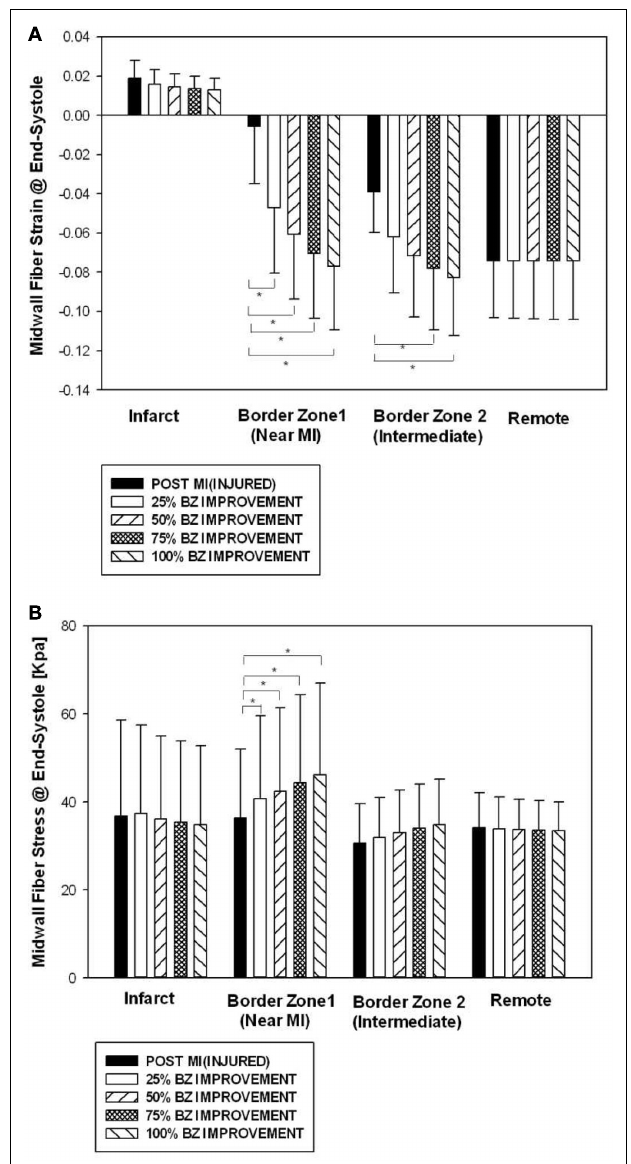
FIGURE 2 | Midwall fiber strain (A) and stress (B) by regions at end systole before and after an increase of 50 and 100% in BZ contractility. Data is presented as mean ± SD. *Signifies p <